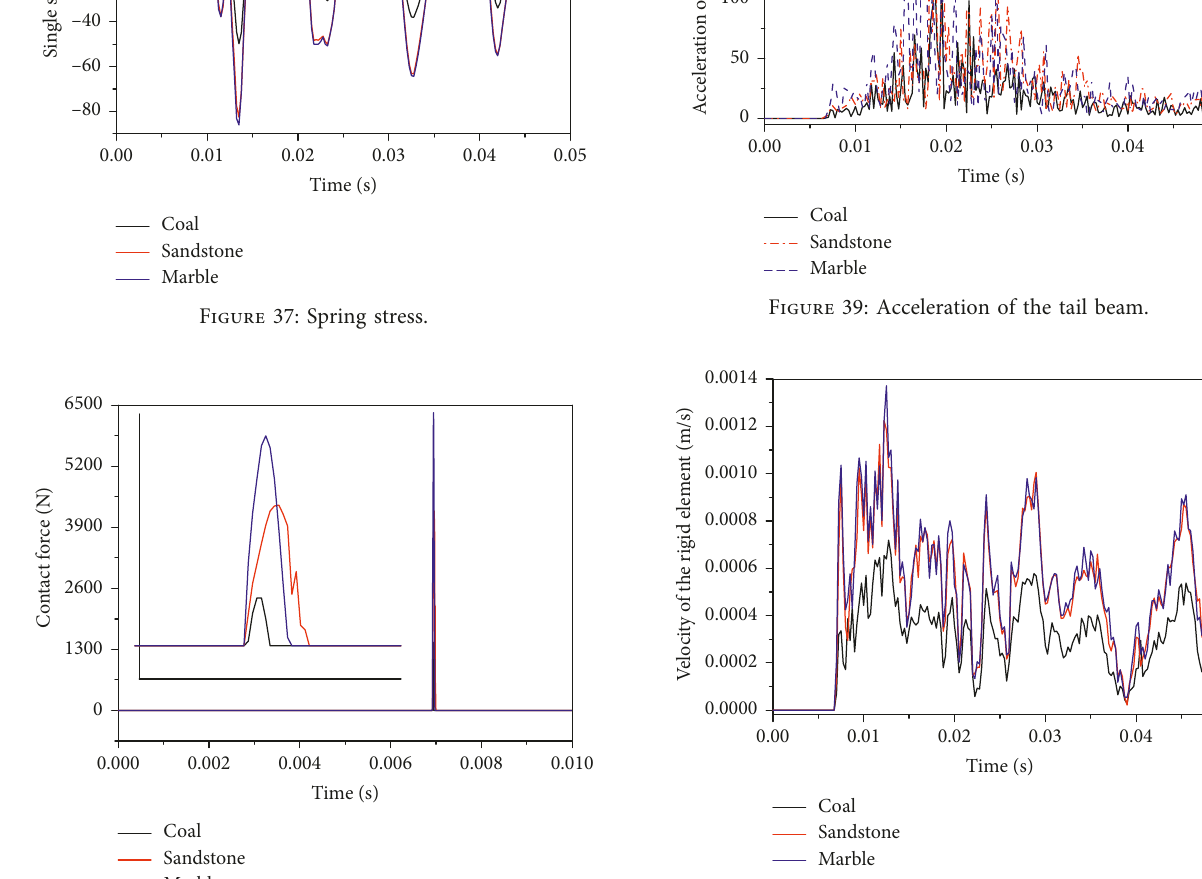
Figure 40: Velocity of the tail